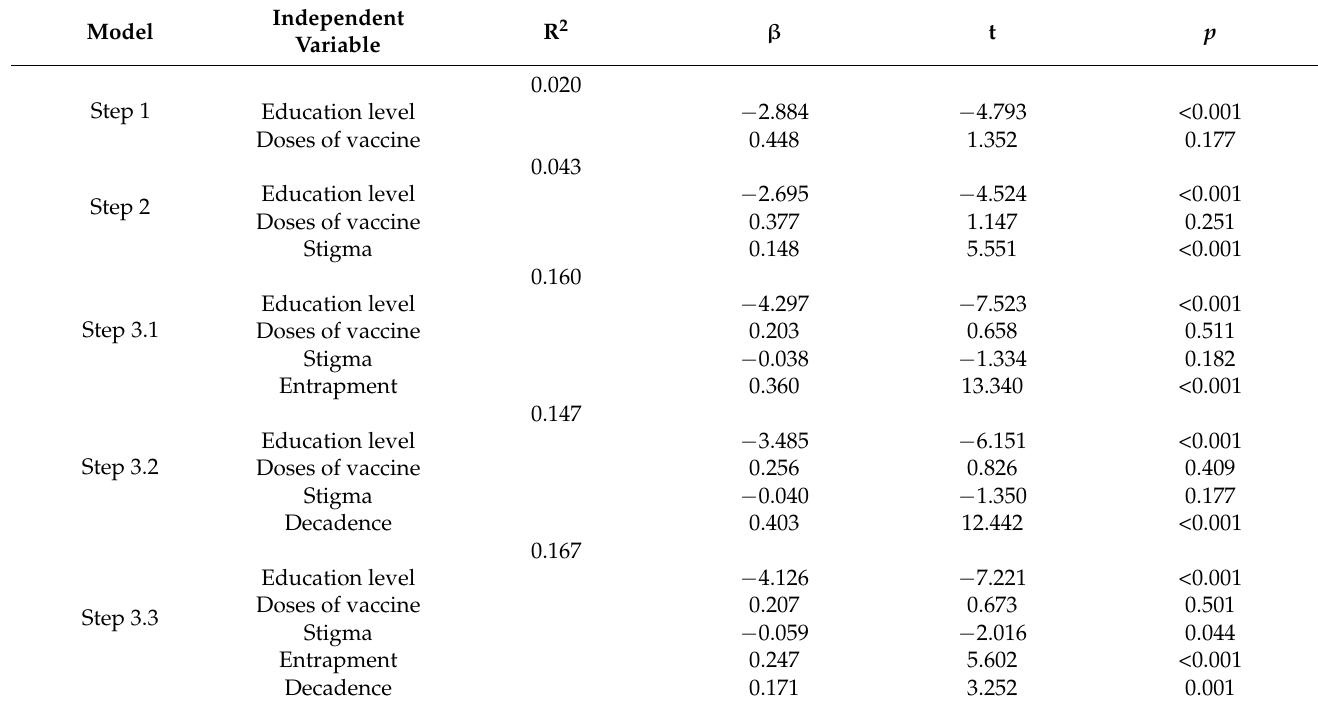
Table 3. Hierarchical regression analysis ( n =